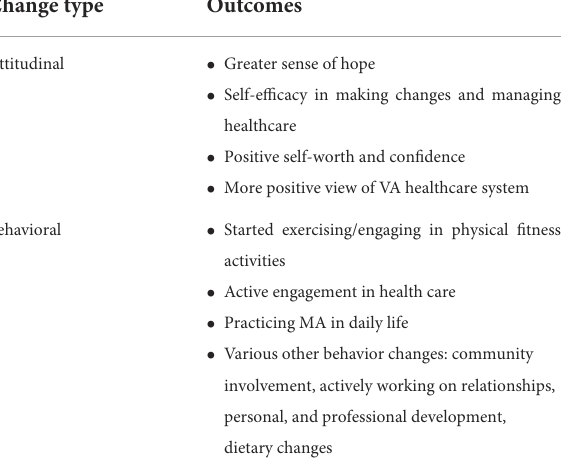
TABLE 3 Themes—reported and observed outcomes for TCMLH program participants. Change